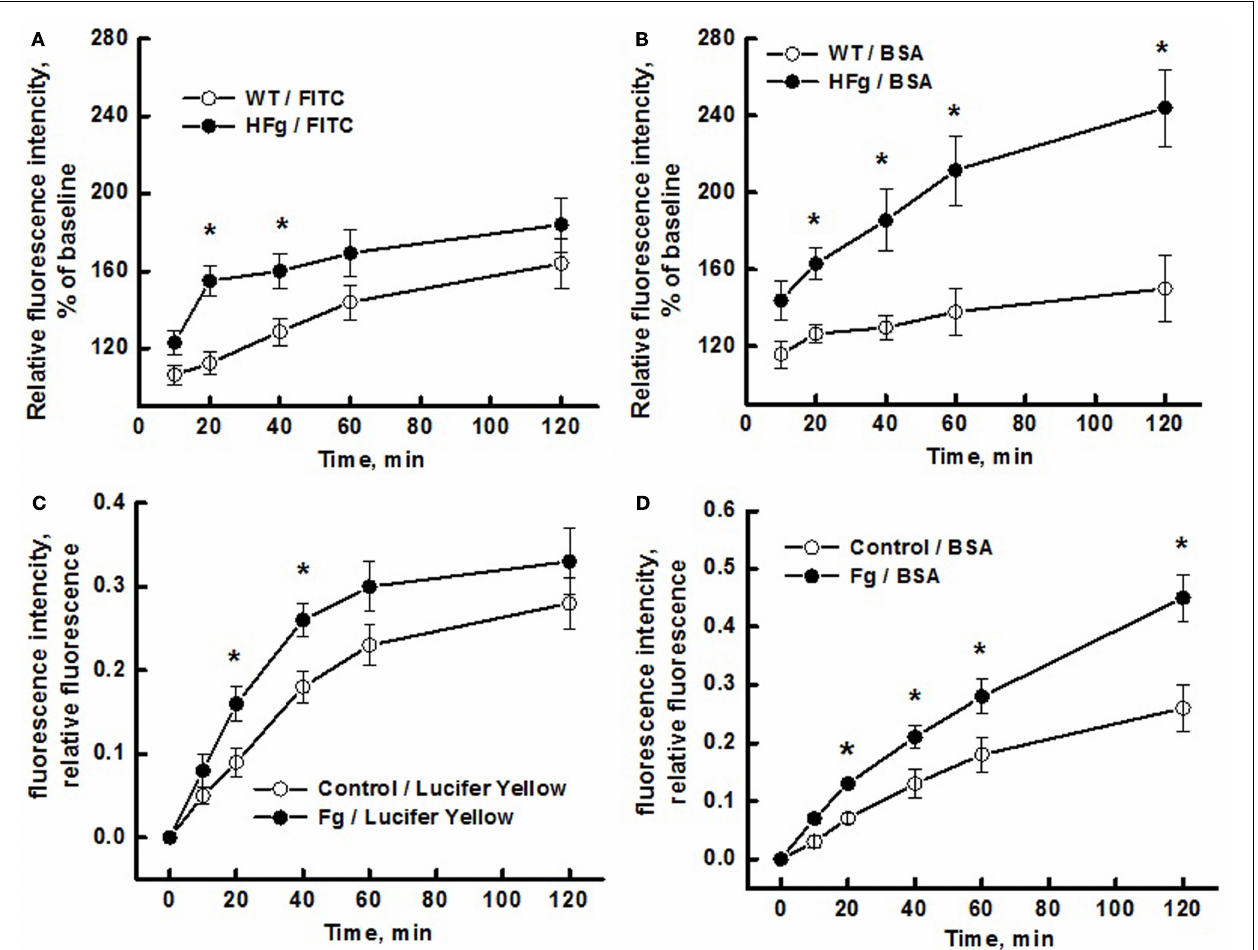
transient opening of the EC junction gaps after infusion of the dye causing the leakage of FITC. However, when the gaps are no longer opened more in HFg mice than inWT mice, enhanced caveolae formation and their function still maintains greater leakage of BSA via transcellular transport. Similarly, the leakage of LuciferYellow was greater through MBECs treated with 4mg/ml of Fg at 20 and 40min after addition of the dye but at 60 and 120min the difference was no longer observed (C) . However, leakage of BSA-647 was more through the MBECs treated with Fg after 20min of addition of dyes (D) .These results confirm the data obtained for mouse pial venules, indicating that HFg affects mainly the transcellular transport through formation of functional caveolae. * p < 0.05 – versusWT or control. n = 6 for animals and n = 8